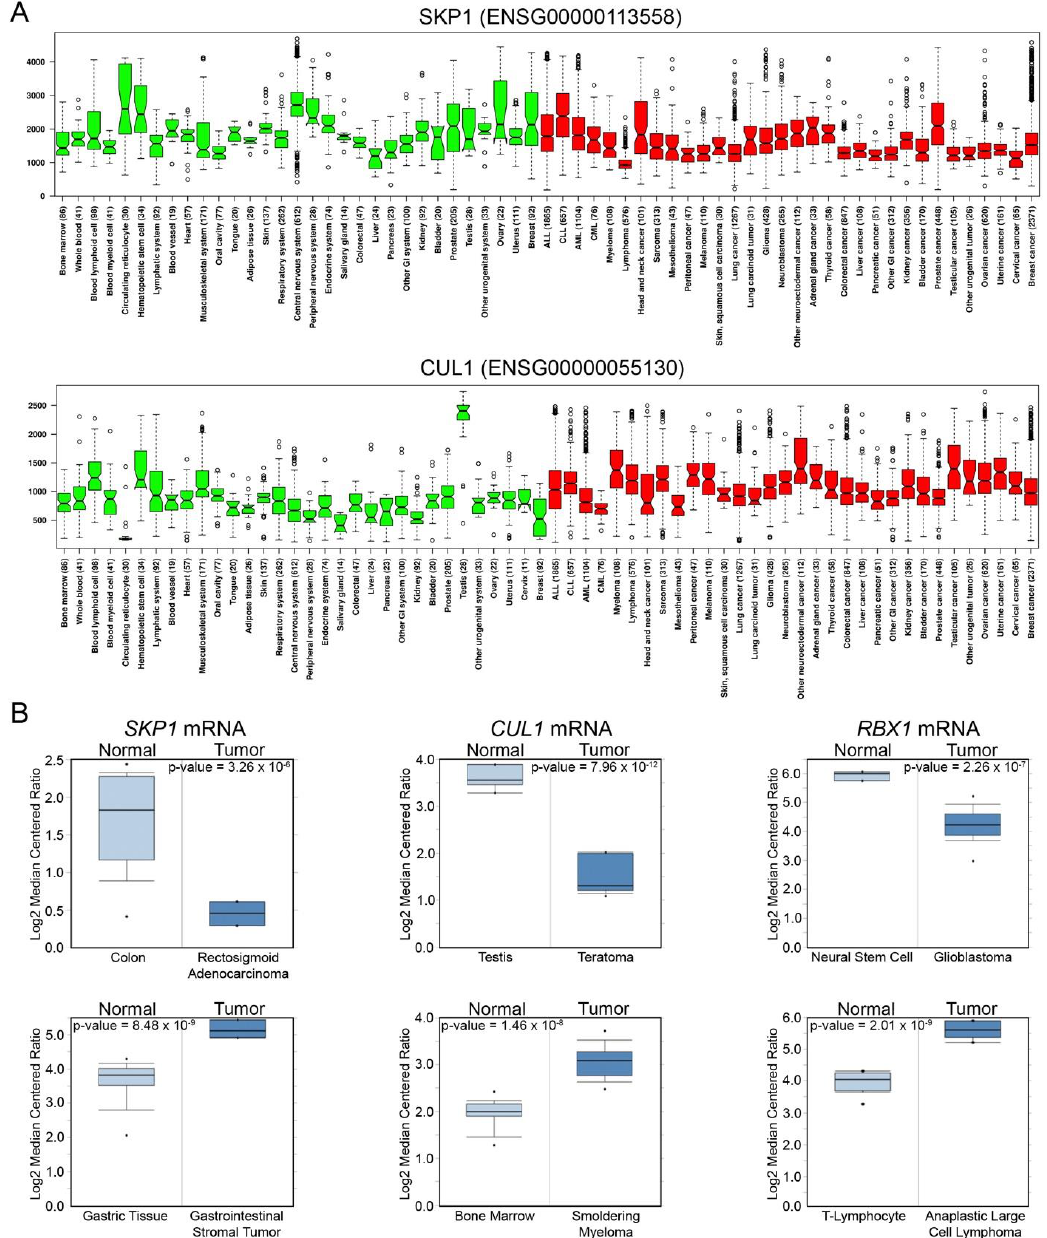
Figure 5. SKP1 and CUL1 exhibit altered expression in numerous cancer types. ( A ) Box-and-whisker plots displaying SKP1 (top) and CUL1 (bottom) mRNA expression levels in healthy (green) and cancer (red) tissues (total cases); RBX1 expression data are not available. Boxes denote the interquartile range (25th, 50 th , and 75th percentiles), while the whiskers extend 1.5-times the interquartile range and open circles identifying outliers. The notches in the boxes allow for visual comparisons between conditions; if two notches are non-overlapping, this is a strong indicator that the medians are different. Data and graph obtained using the in silico transcriptomics (IST) database [94]. In general, SKP1 mRNA expression levels are frequently reduced in cancers relative to the corresponding normal tissues, whereas CUL1 levels are predominantly increased. ( B ) Box plots displaying SKP1 , CUL1 , and RBX1 mRNA expression levels for normal and tumor tissues. Boxes display the interquartile range with black dots identifying minimum/maximum values. Note that the top graphs display instances where significant decreases in mRNA expression occur within the tumors relative to normal tissue, while the bottom graphs provide examples where significant increases in expression occur. Graphs and statistical analyses were generated using the Oncomine database [95].